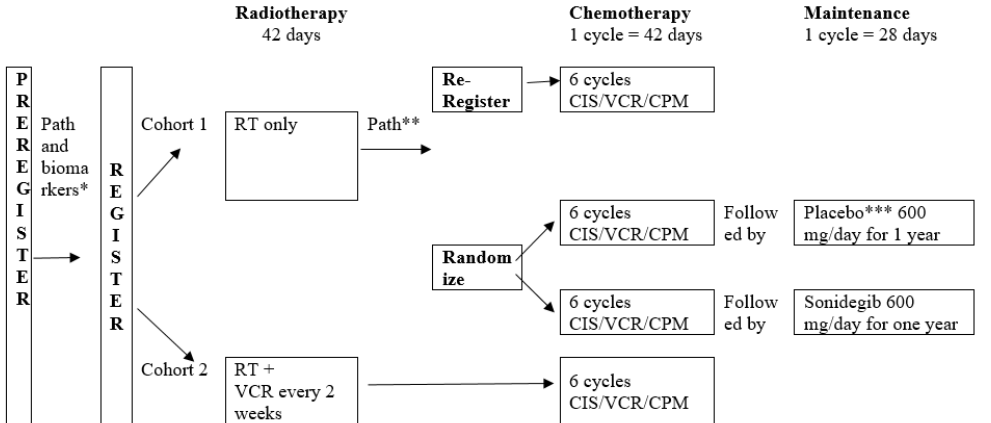
Figure 1. Overall schema of the AMBUSH trial (A072001) for patients 18 years of age at diagnosis or older with medulloblastoma or pineal embryonal tumors. * Preregister on study and begin clinical staging, RT plan preparation. Central pathology review and biomarker assays: IHC, DNA seq, CNA and clinical staging (postoperative brain MRI, spinal MRI, CSF analysis) required to assign to cohort: Cohort 1: average risk MB (non-SHH or SHH arms); Cohort 2: high risk MB or any PET. ** Final integrated pathological diagnosis including results of DNA methylation for MB subgroup confirmation (SHH vs. Non-SHH—Group 4, WNT). *** Patients receiving placebo who relapse will be allowed to crossover. Abbreviations: RT: radiotherapy; MB: medulloblastoma; IHC: immunohistochemistry; DNA seq: DNA sequencing; CNA: copy number assessment; SHH: sonic hedgehog; yo: years old; GTR: gross total resection; NTR: near total resection; M0: no metastatic disease; M1–3: any metastatic disease; CSI: craniospinal irradiation; q2wk: every other week;